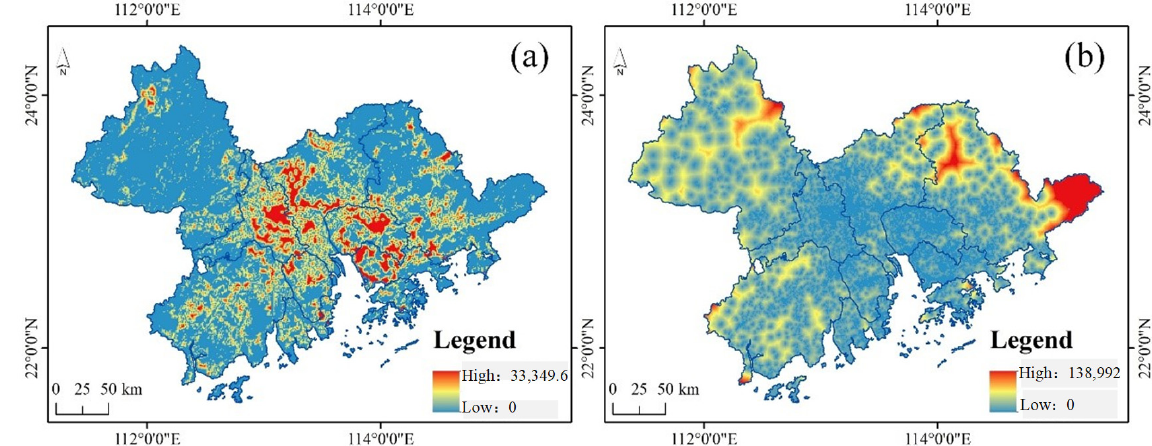
Figure 6. Resistance surface of ( a ) construction and ( b ) non-construction land.